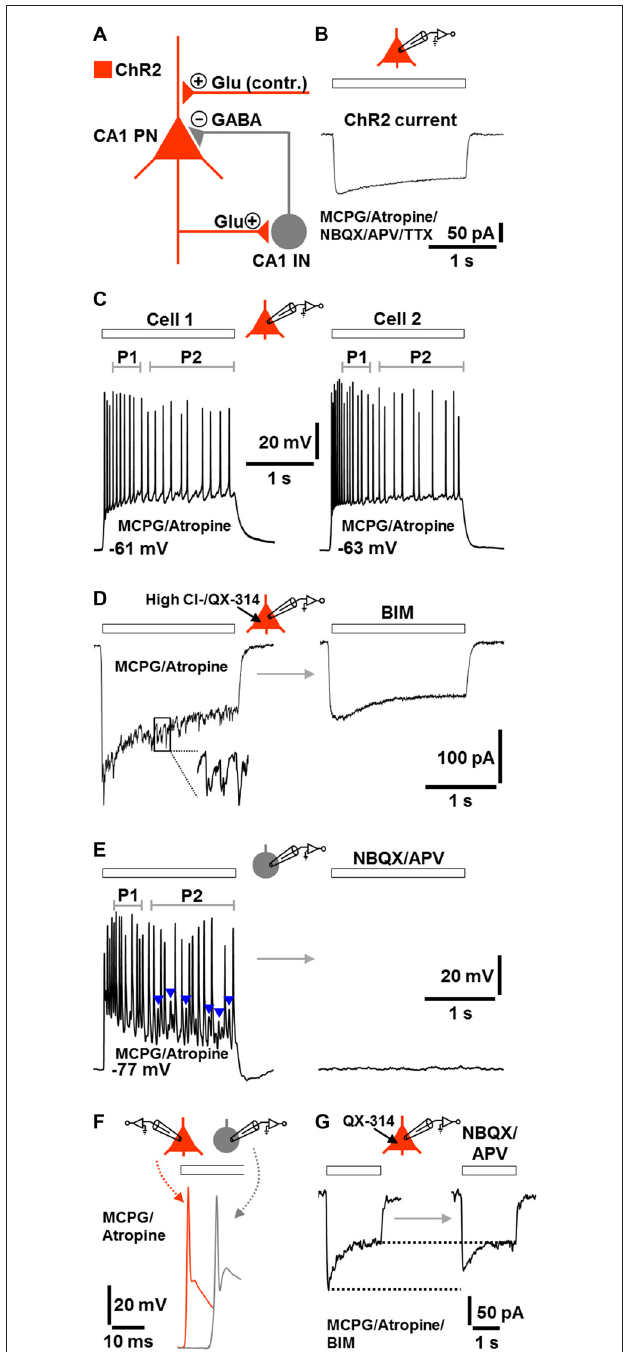
FIGURE 3 | Model of the network components and signaling modalities underlying or contributing (contr.) to the optogenetically induced fast CA1 oscillations under group I/II mGlu/mACh receptor blockade (A) and corroborative single-cell activities during ChR2 activation (B–G; Glu, glutamate). All recordings were performed in the continuous presence of MCPG and atropine. If not stated otherwise, recordings were made using a K-gluconate-based intracellular solution. Halogen light intensity was always 12 mW/mm 2 . Holding potential in voltage-clamp measurements was − 70 mV. Application time of drug(s) in (D,E,G) was 10 min. (B) ChR2 ( Continued